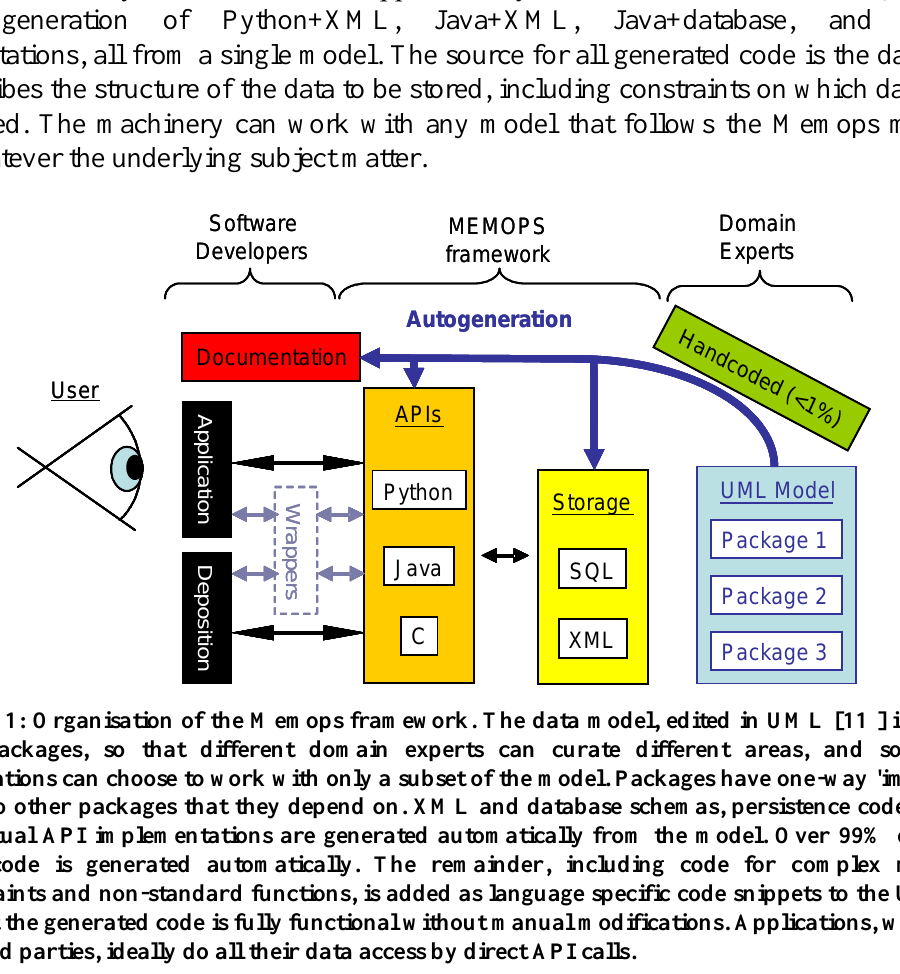
s ) r( ho u t A he T 2010 gh t i y r op C